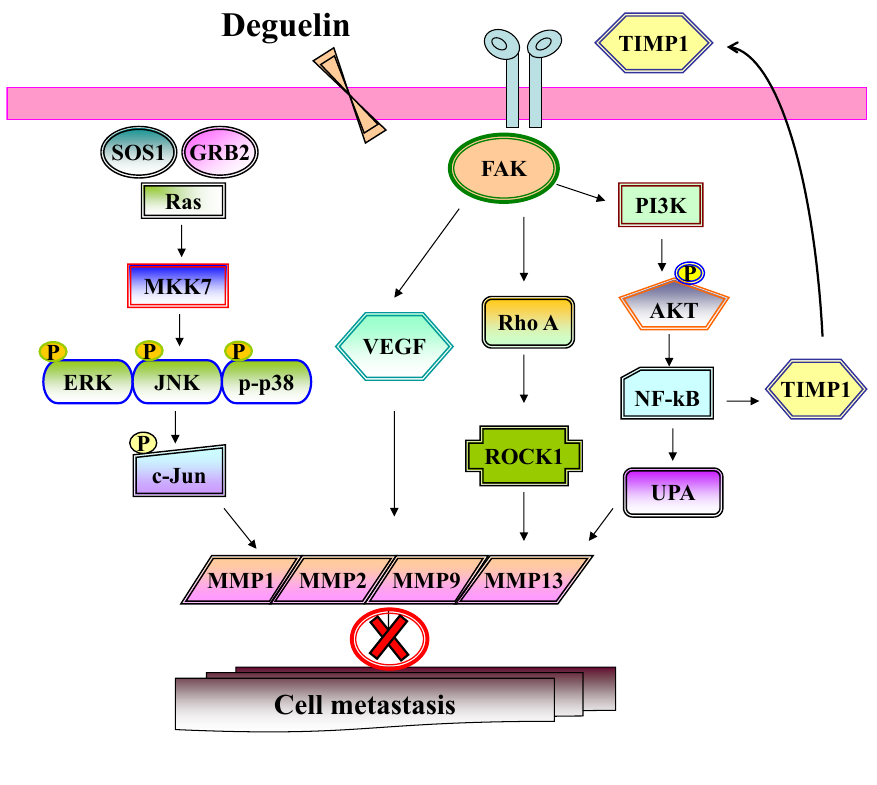
Figure 9. The possible signaling pathways for deguelin inhibited cell invasion and migration in U-2 OS human osteosacroma